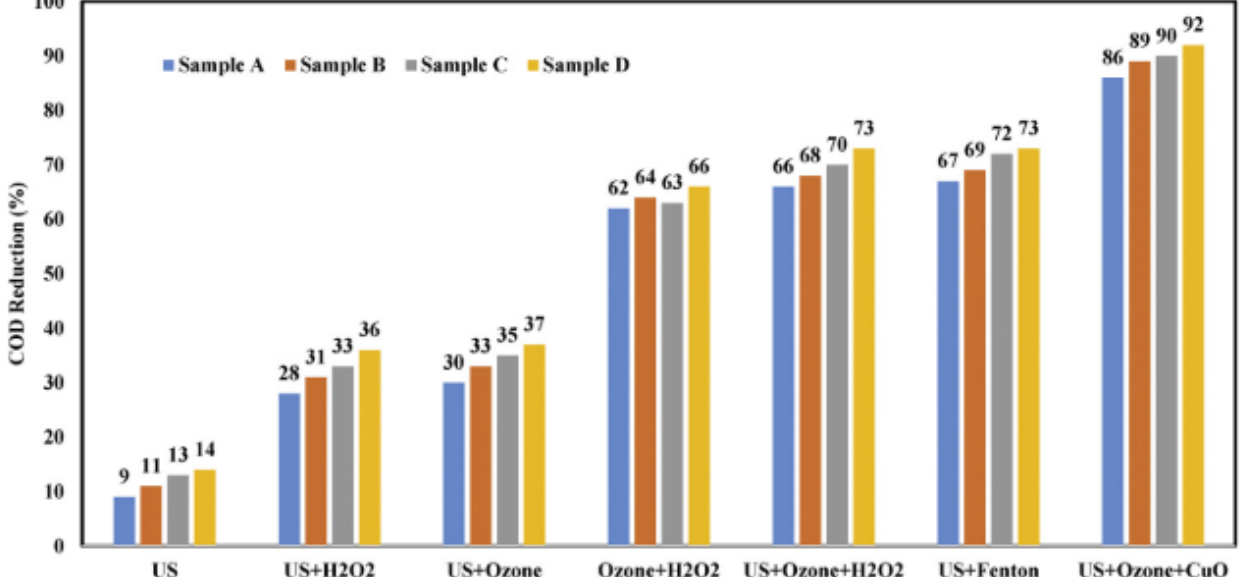
Figure 7. Comparison of different approaches for the COD reduction of various PIE samples. Reprinted with permission from [45].